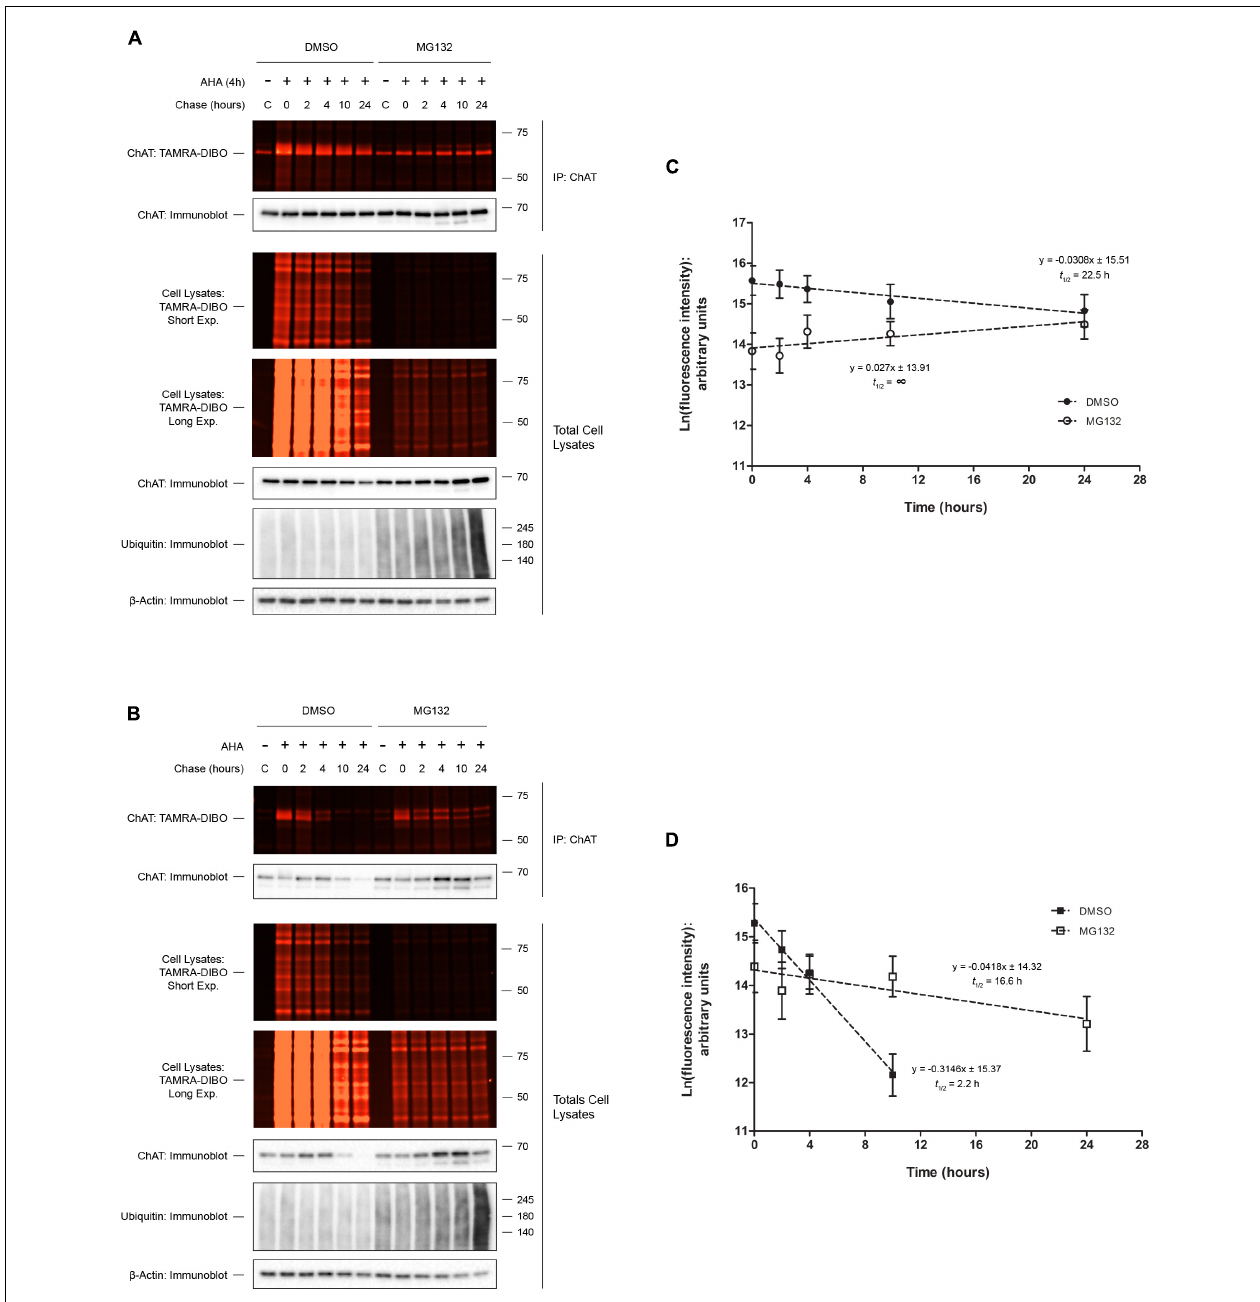
FIGURE 3 | Proteasome inhibition increases ChAT protein half-life. Fluorescence detection of immunoprecipitated (IP) AHA/TAMRA-labeled wild-type (WT; A ) or P17A/P19A-ChAT (B) from transiently transfected SN56 cells following SPAAC pulse-chase (4 h AHA pulse, 0–24 h methionine chase) with the strained cyclooctyne TAMRA-DIBO. Cells were treated with either DMSO-control or 5 µ M MG132 throughout both the 4 h AHA pulse and the 24 h chase periods (up to 28 h total). Control unlabeled cells were incubated in media with methionine (i.e., without AHA). Fluorescent AHA/TAMRA-labeled proteins from either whole cell lysates or anti-ChAT IPs were detected in resolved SDS-PAGE gels at an Ex/Em of 555/580 nm. Anti-ChAT and anti-actin immunoblots were completed on AHA/TAMRA-labeled protein samples for downstream data analysis and as loading controls. (C) Proteasome inhibition by MG132 treatment increased the protein half-life of wild-type ChAT (no protein decay) as compared to DMSO-treated control cells (22.5 h). Wild-type ChAT fluorescence intensities from (A) were plotted on a semi-logarithmic scale and linear regression was completed to determine wild-type ChAT protein half-life. The slopes of decay for DMSO- and MG132-treated cells were significantly different from each other: F (1,46) = 4.79241, p ≤ 0.05, n = 5. (D) Proteasome inhibition by MG132 treatment increased the protein half-life of mutant P17A/P19A-ChAT (16.6 h) as compared to DMSO-control (2.2 h). ChAT fluorescence intensities from (B) were plotted on a semi-logarithmic scale and linear regression was completed to determine P17A/P19A-ChAT protein half-life. The slopes of decay for DMSO- and MG132-treated cells were significantly different from each other: F (1,41) = 18.9864, p ≤ 0.0001, n = 5. A 24 h time point was not included for the quantification of P17A/P19A-ChAT half-life in DMSO-treated cells as the fluorescence intensity was indistinguishable from